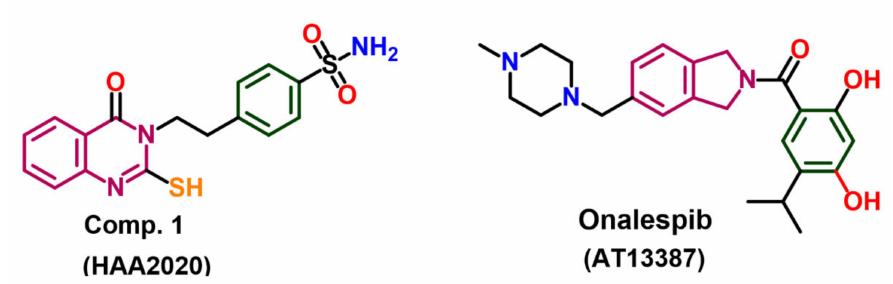
Figure 2. Chemical structure of HAA 2020 and